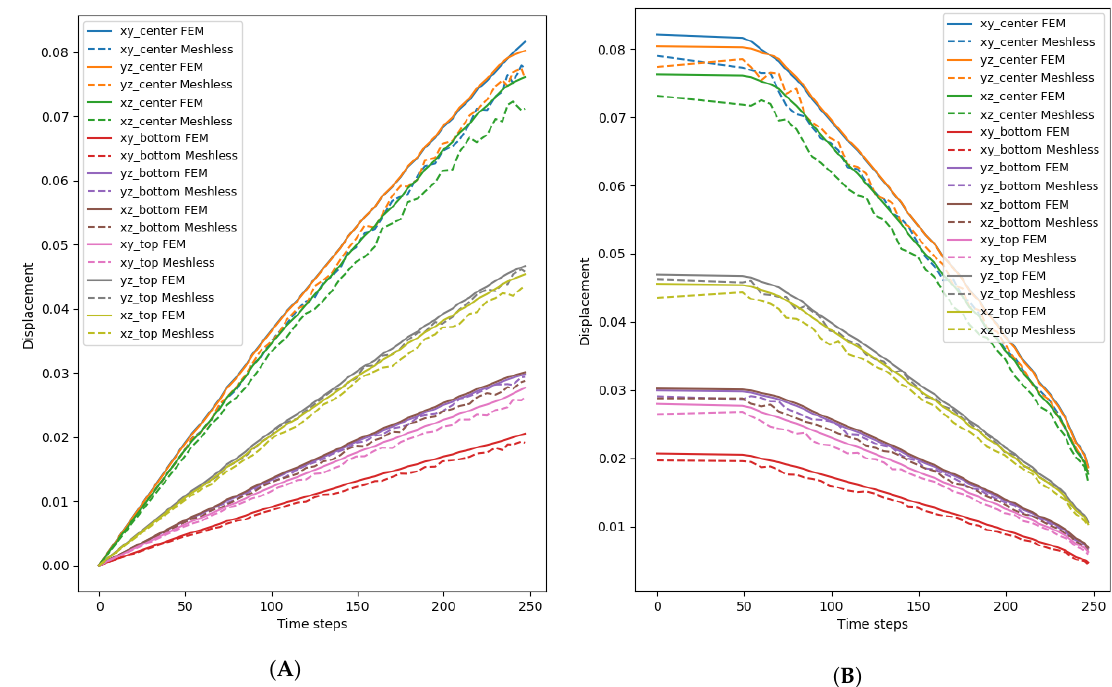
Figure 11. Mean displacement of the vastus lateralis. ( A ) shows the mean displacement for the contraction step, ( B ) shows the mean displacement for the expansion